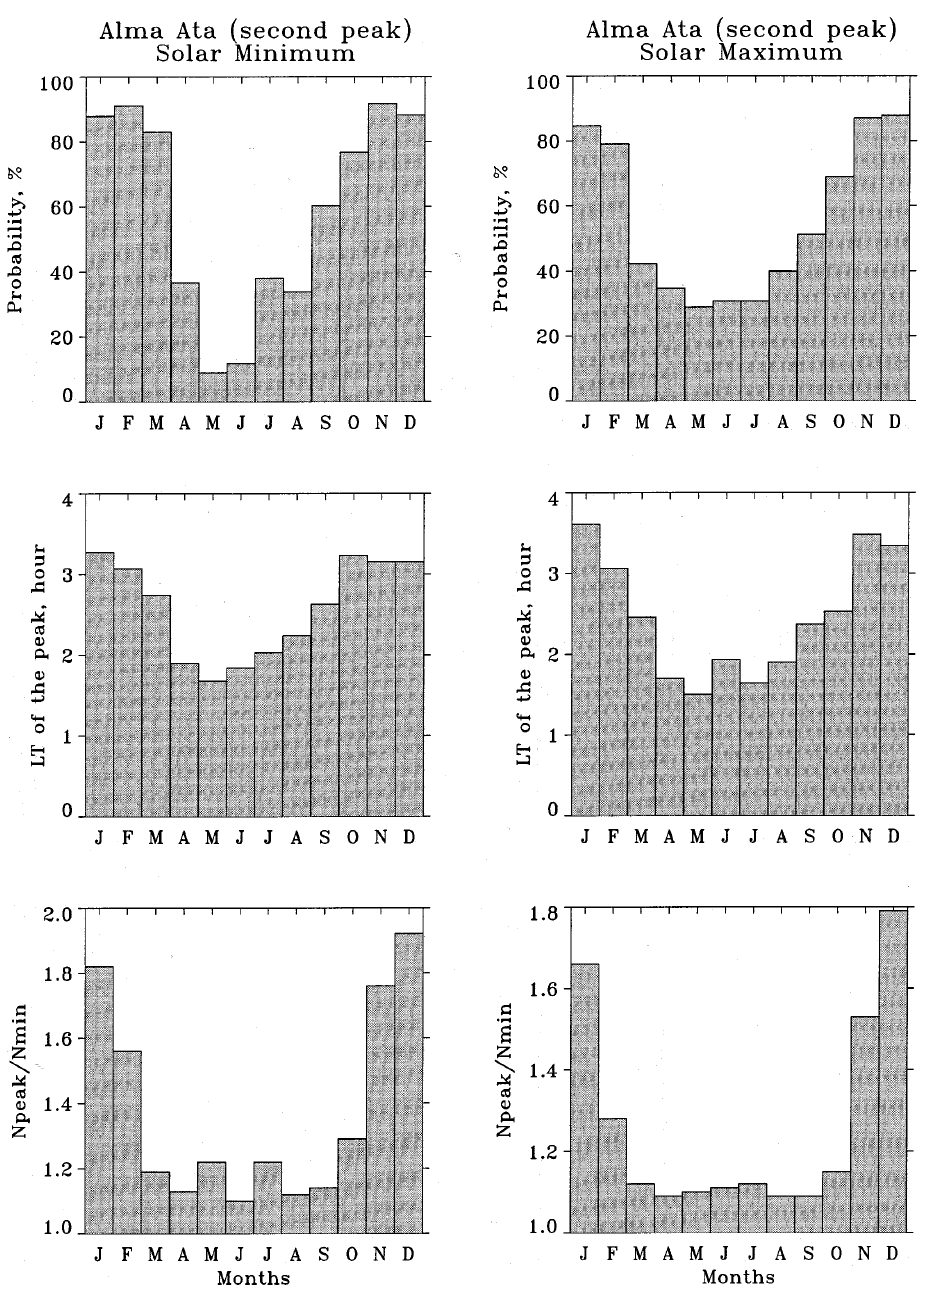
Fig. 3. Same as Fig. 2 but for the